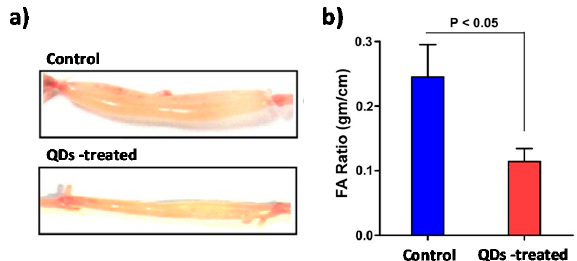
Figure 9. ( a ) Image of isolated mouse intestinal loop 6 h after the injection of 1 μ g of CT and 1.25 μ g μ L − 1 of ZnO QDs or only CT in the control one; ( b ) Fluid accumulation (FA) ratio after 6 h of injection; (n = 10 mice with 15–20 loops studied per group). Reproduced with permission from [90]. Elsevier, 2016.